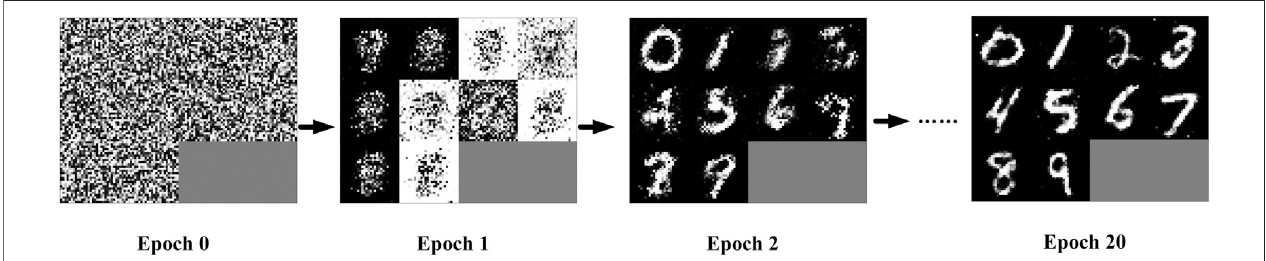
FIGURE 1 | The schematic diagram for the effects of GAN in generating images within the iterative training